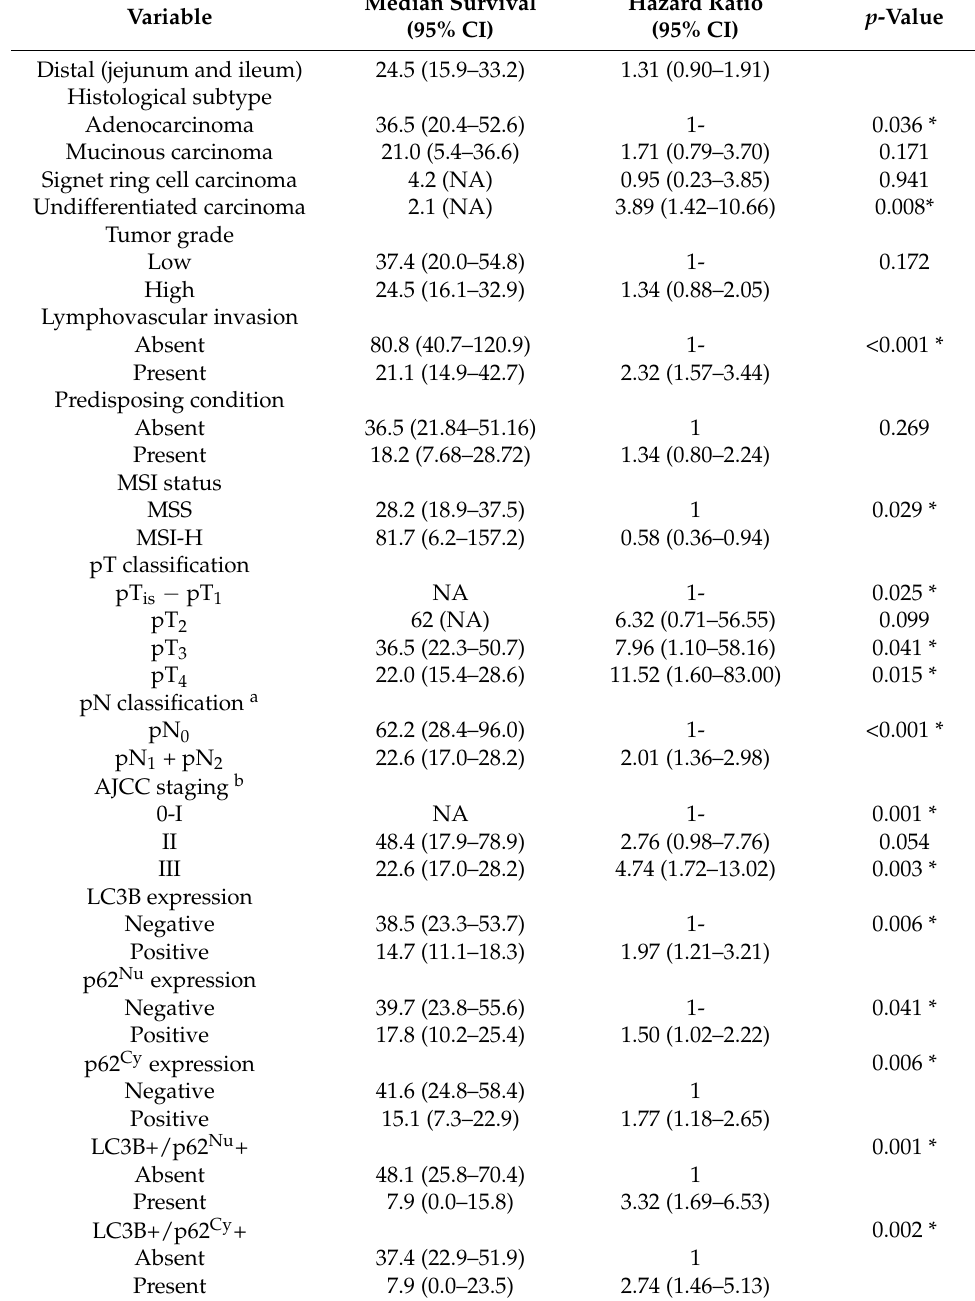
a Calculated only 166 cases with available information of lymph node metastasis. b Calculated only 166 cases with available information of the AJCC stage. * Statistically significant ( p < 0.05). Multivariate analysis indicated that MSS ( p = 0.004), higher T stage ( p = 0.005), lymph node metastasis ( p = 0.013), and LC3B+ expression ( p = 0.025) were independent prognos- tic factors (Table 6). The hazard ratio for SIAC with LC3B+ expression was 1.817 (95% confidence interval, 1.077–3.064) compared to that of LC3B −